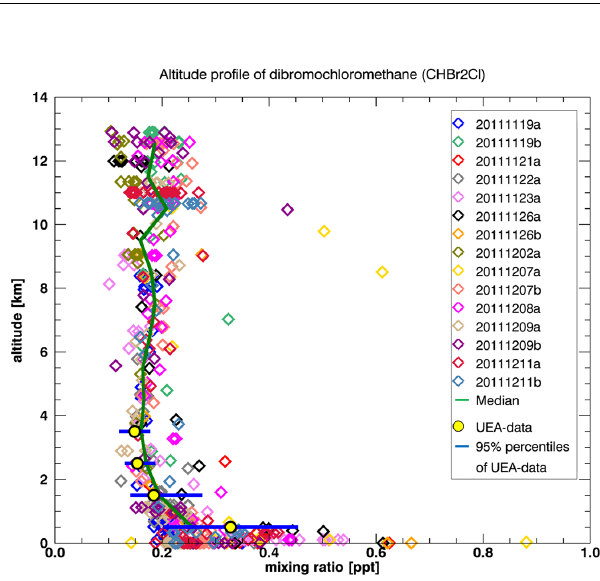
Figure 7. As Fig. 3, for CHBr 2